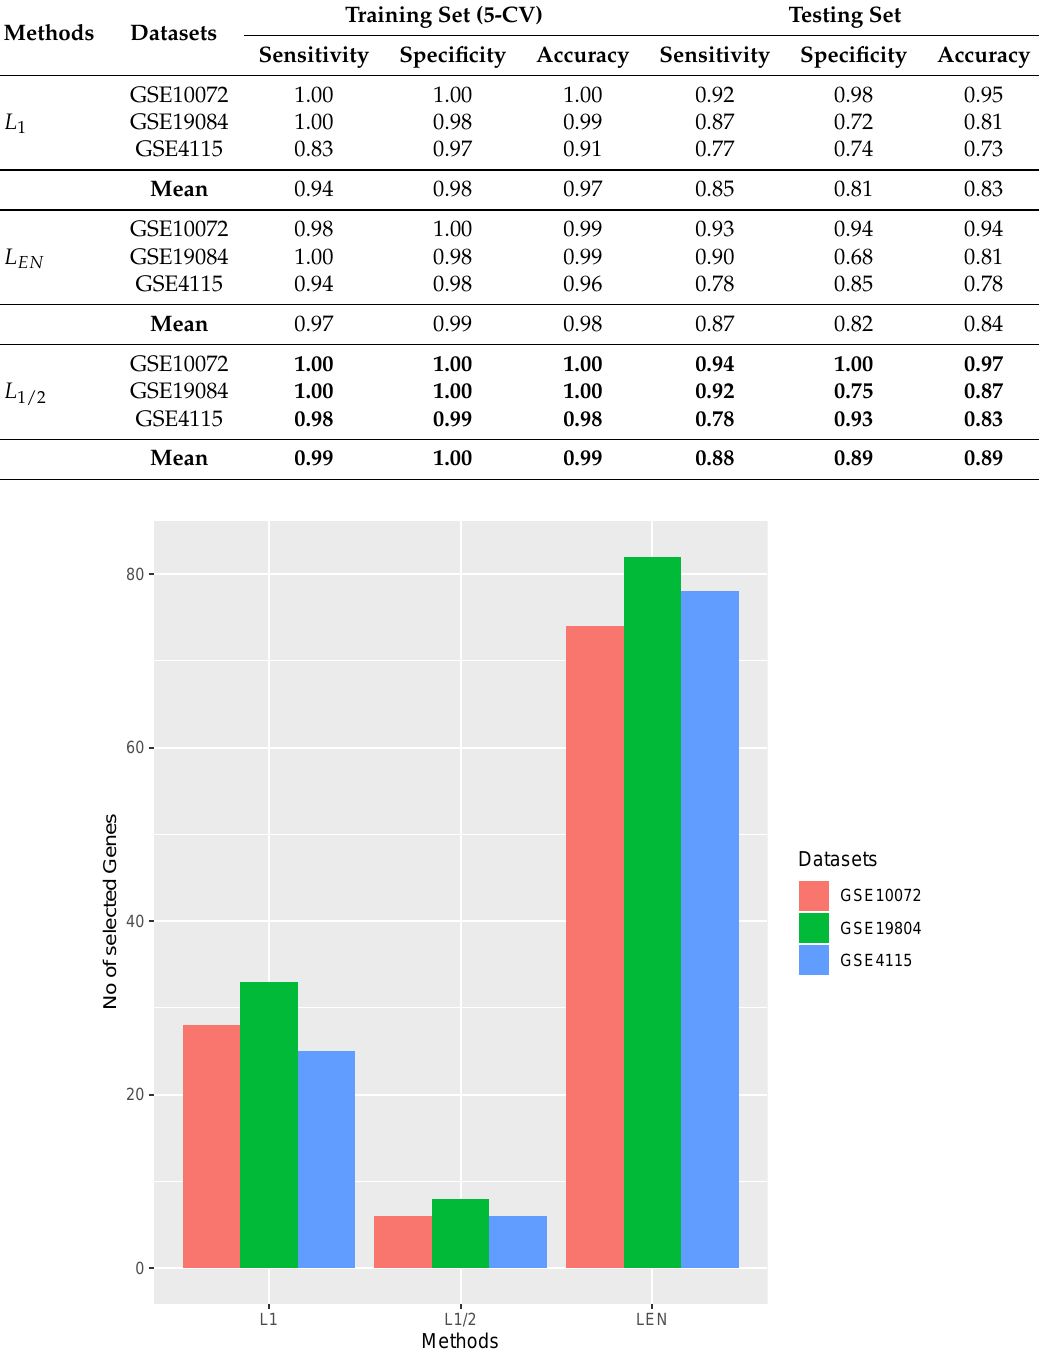
Table 3. Mean results of empirical datasets. The results of our proposed method are given in bold.